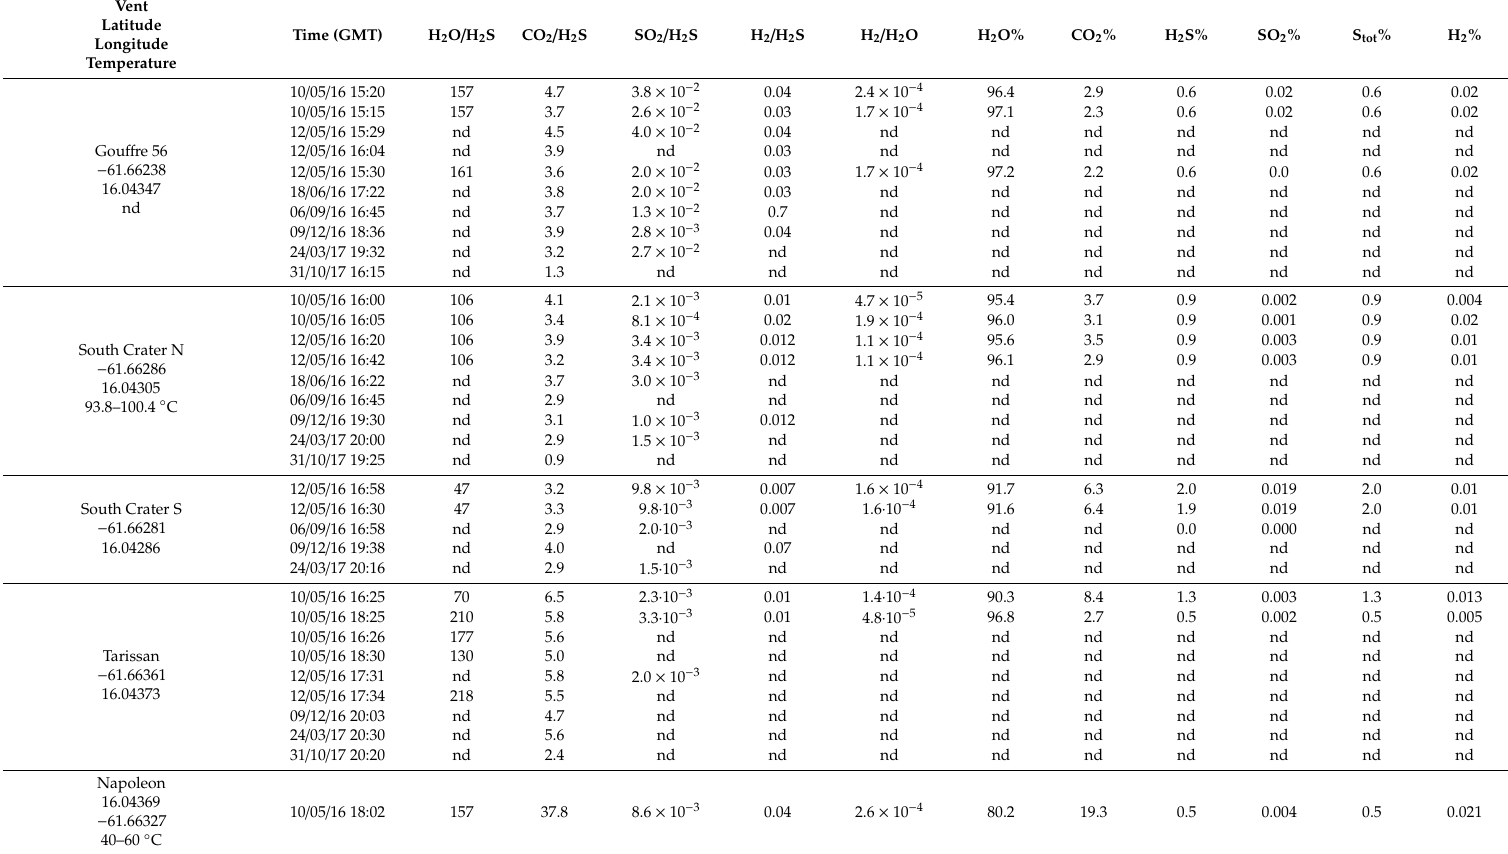
Table 1. Molar gas ratios in fumarolic emissions from La Soufri è re volcano measured with MultiGAS in 2016-2017. Coordinates and gas temperature ranges are given for each fumarole. Overall molar compositions are reported only when H 2 O was